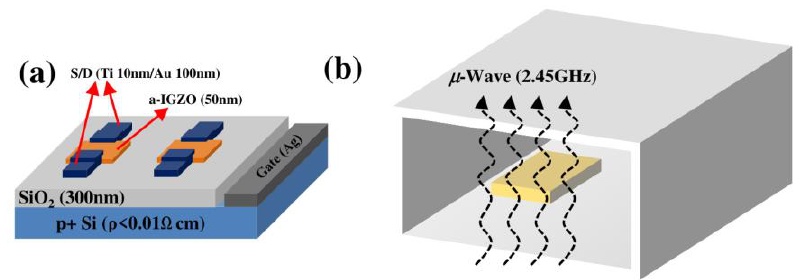
Figure 1. ( a ) Schematic diagram of an a-IGZO TFT and ( b ) concept of the microwave-assisted annealing process.